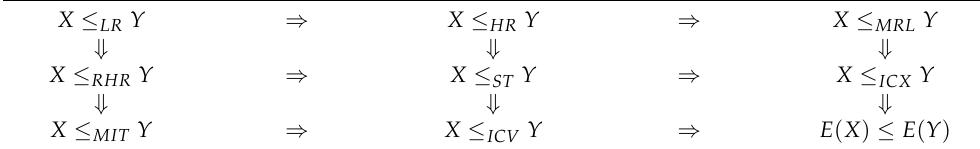
Table 1. Relationships among the main stochastic